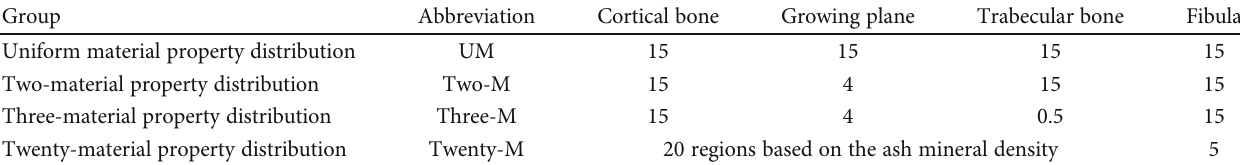
Table 4: Di ff erent material property distribution used in the study